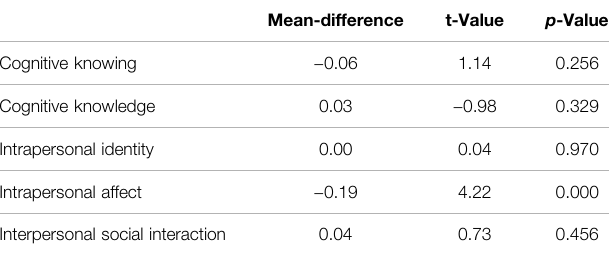
TABLE 5 | Paired-sampled t -test of Students ’ Global perspectives in Pre- and Post-survey.